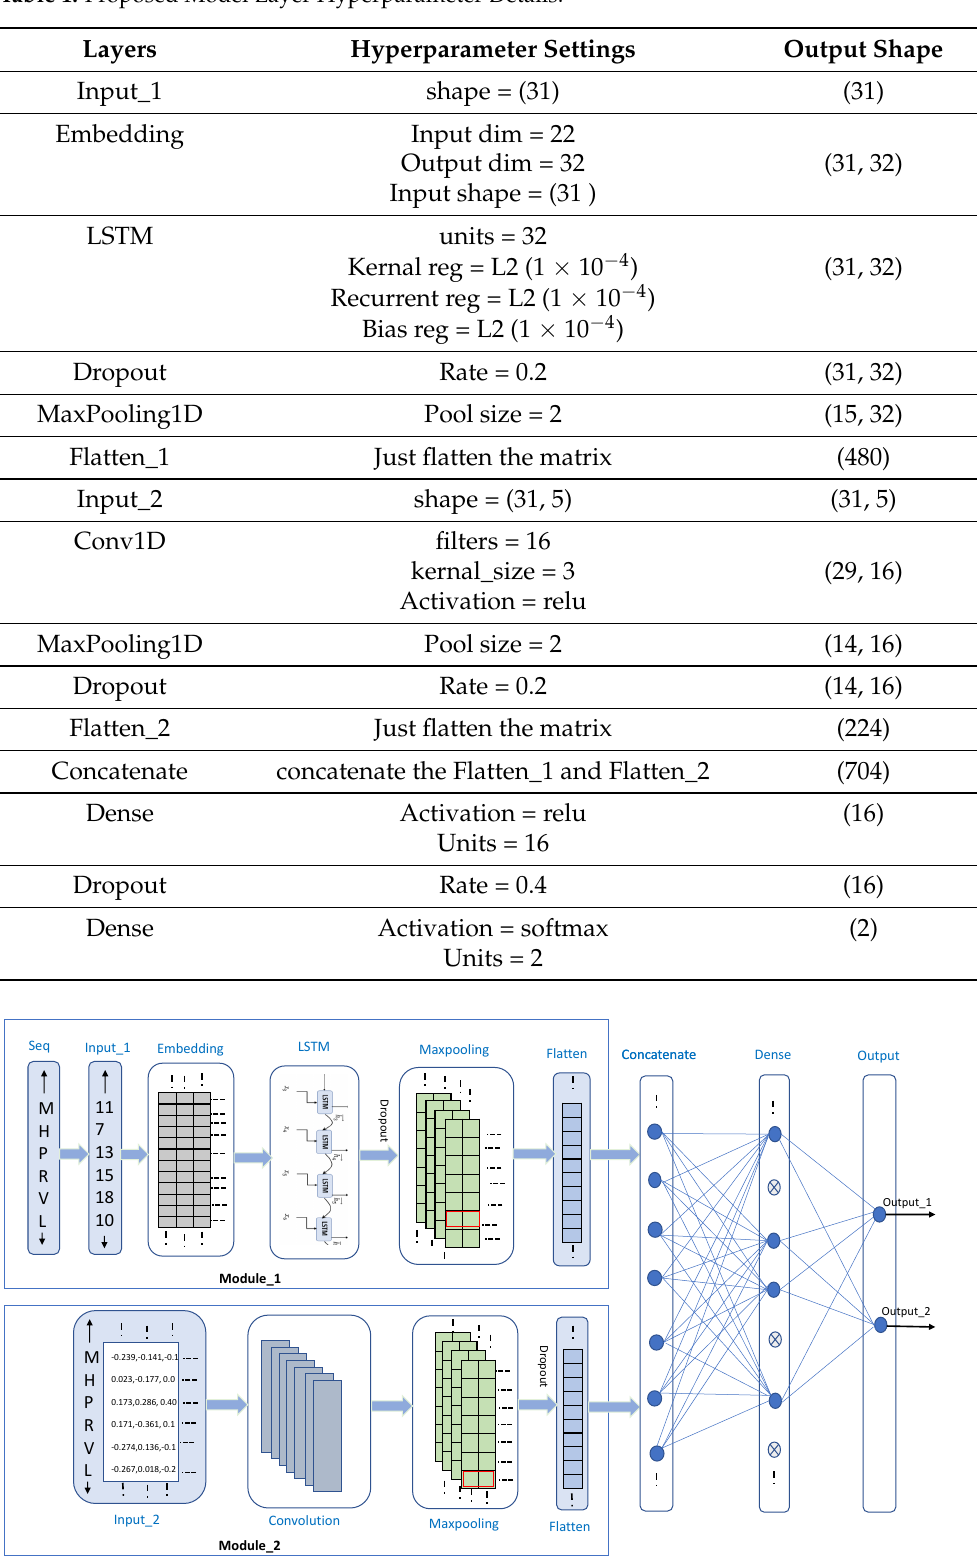
Figure 1. Proposed model